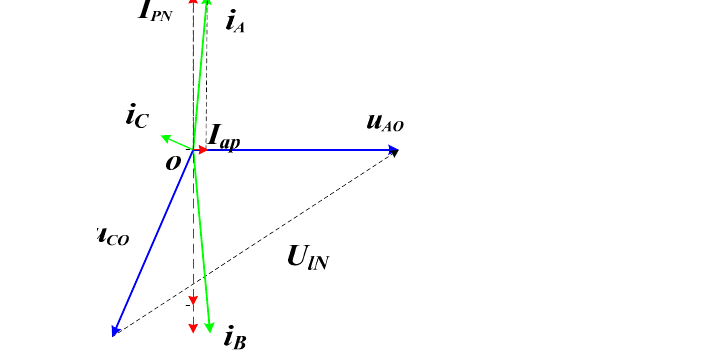
Figure 4. The voltage and current vector diagram of the recommended voltage-current combination.